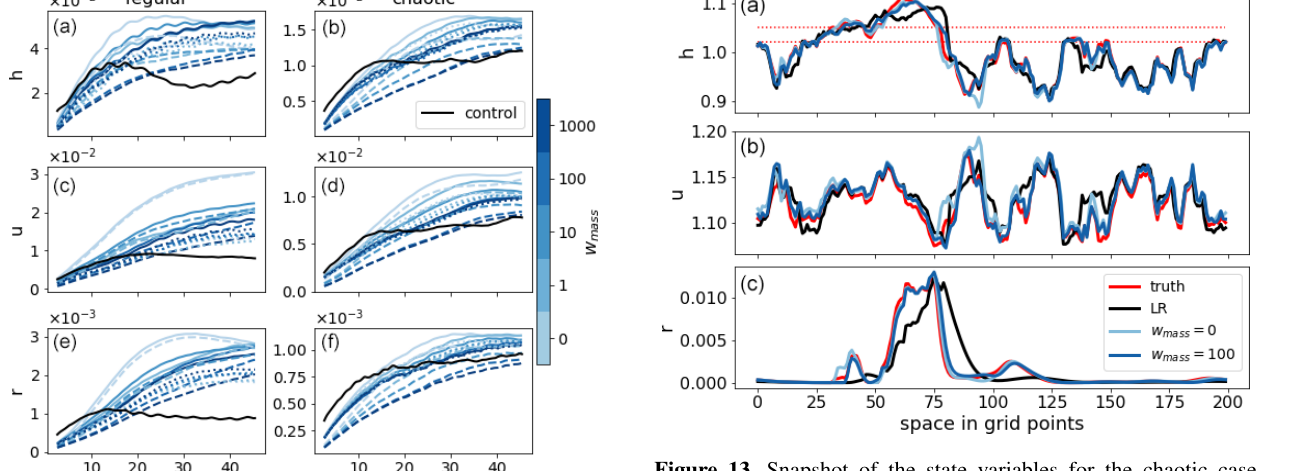
Figure 13. Snapshot of the state variables for the chaotic case of a 6h forecast starting from initial conditions of the validation dataset for the truth (red), LR (black), and LR ANN corresponding to weightings w mass = 0 (light blue) and w mass = 100 (dark blue). The dotted red lines are the convection threshold H c and rain thresh- old H r ,